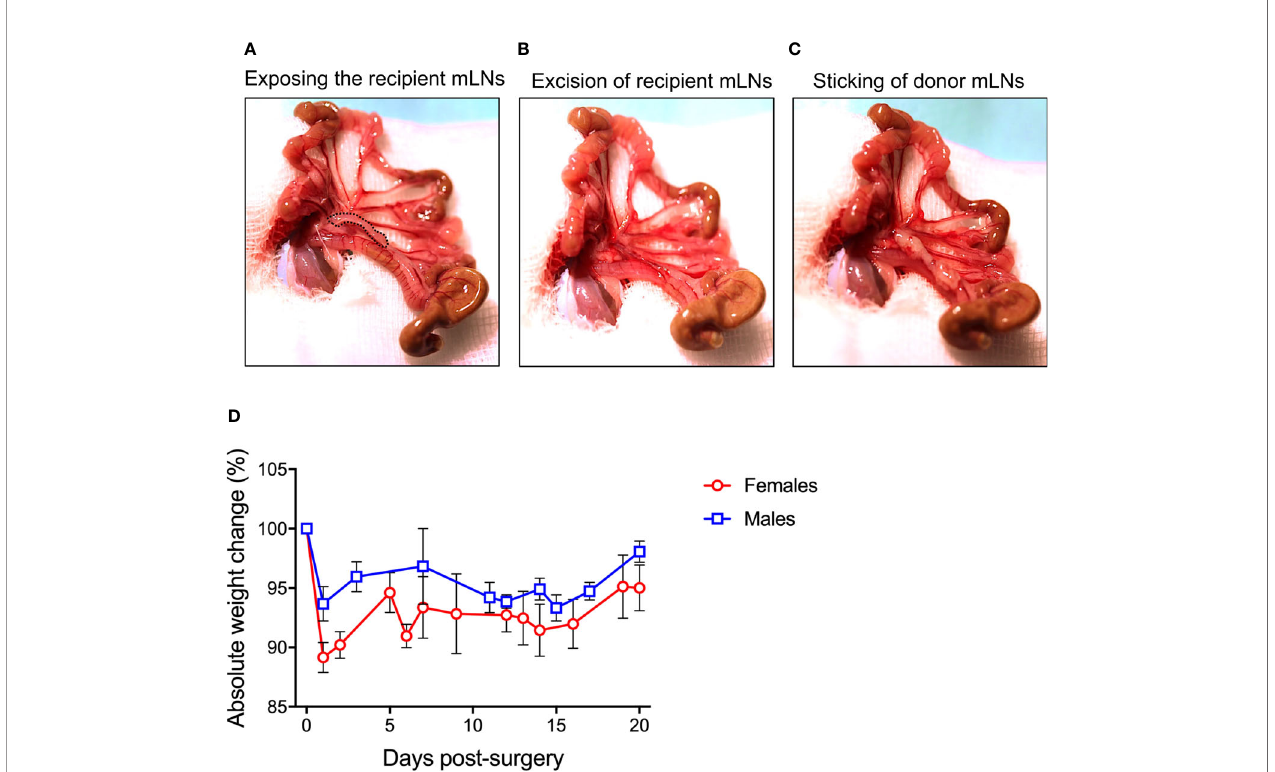
FIGURE 1 | Procedure of mesenteric lymph node (mLN) transplantation. (A) Peritoneal cavity of the mice was carefully opened and the bowel along with the caecum taken out and laid on DPBS-wetted gauze pad to make all the mLNs lobes visible. (B) All the lobes of recipient mLNs were excised out avoiding bleeding from the superior mesenteric artery lying behind the mLNs (C) 10 m l of fi bronectin were pipetted on the scar, donor mLNs soaked in thrombin were carefully placed on the scar and incubated for 3-5 min before internalizing the complete bowel for subsequent suturing. (D) Absolute weight change of male and female mice undergoing surgical